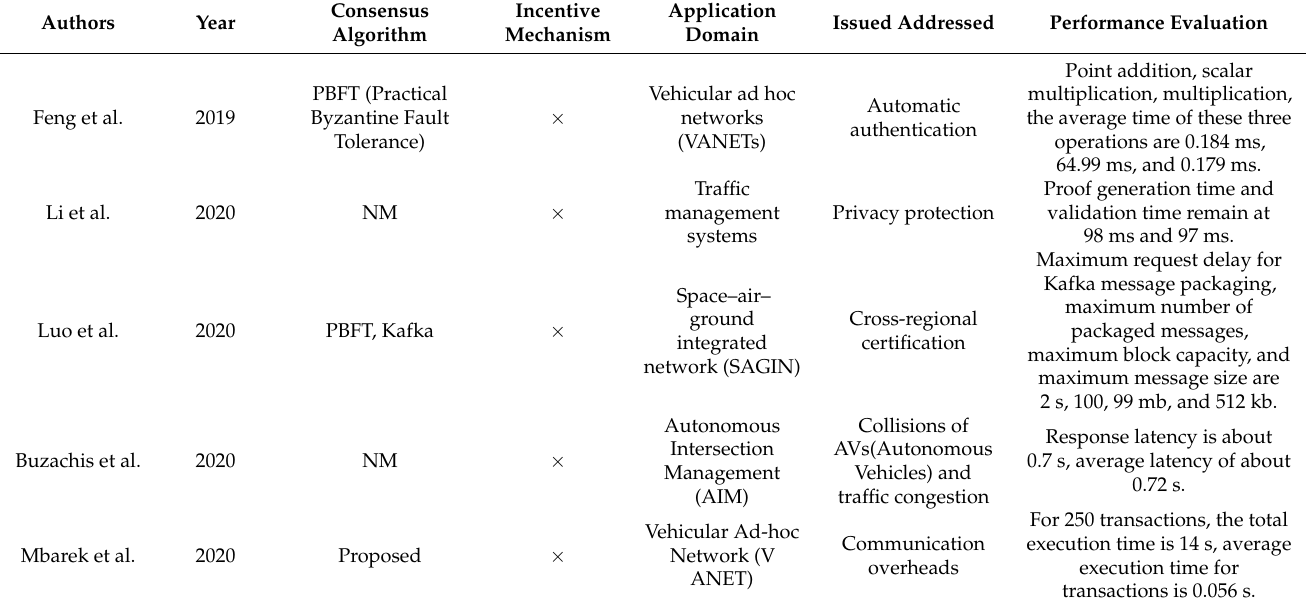
Table 6. Differences between schemes of smart transportation (NS: mention but not specify, NM: not mentioned).